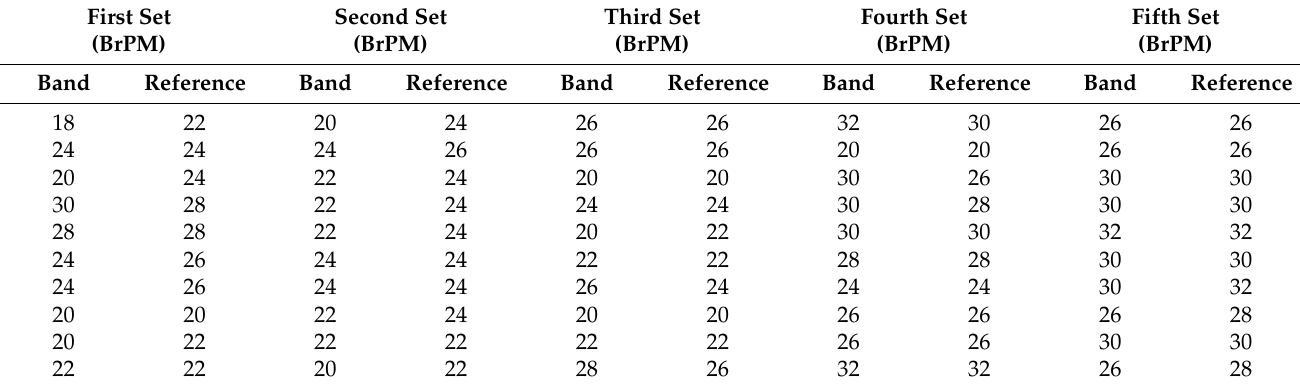
Table 4. Measurements obtained with the various tested parameter sets; in the left column, the measurements provided by the band are reported on, whereas, in the right column, the corresponding reference measurements are